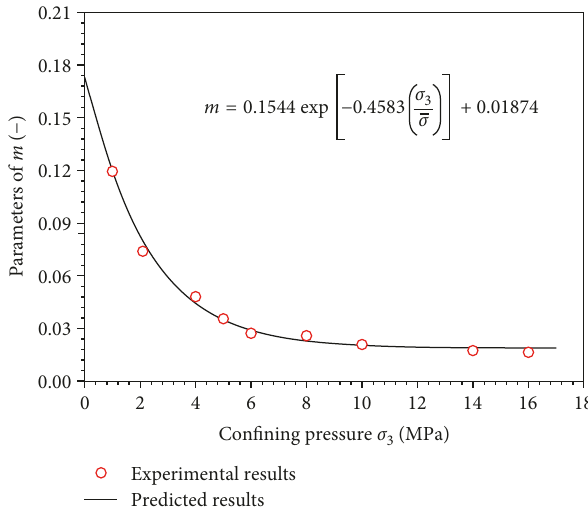
Figure 12: The relationship between the parameter m and con- fining